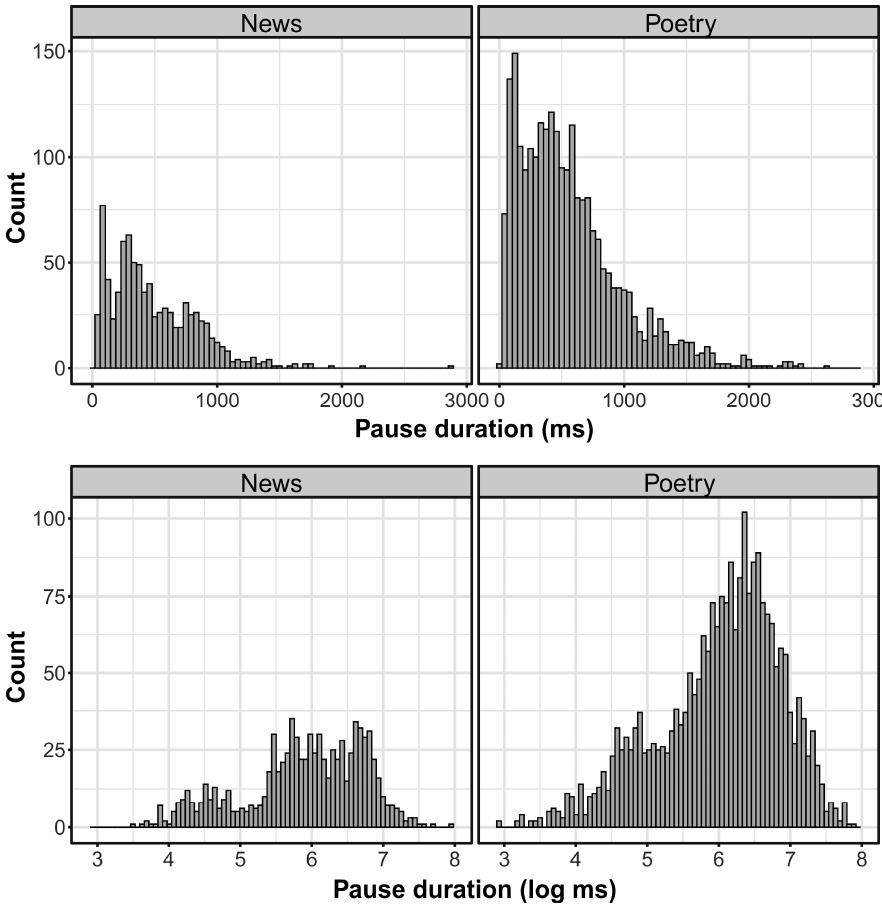
Figure 2. Histograms of pause duration (raw or logarithmic) in two types of materials.